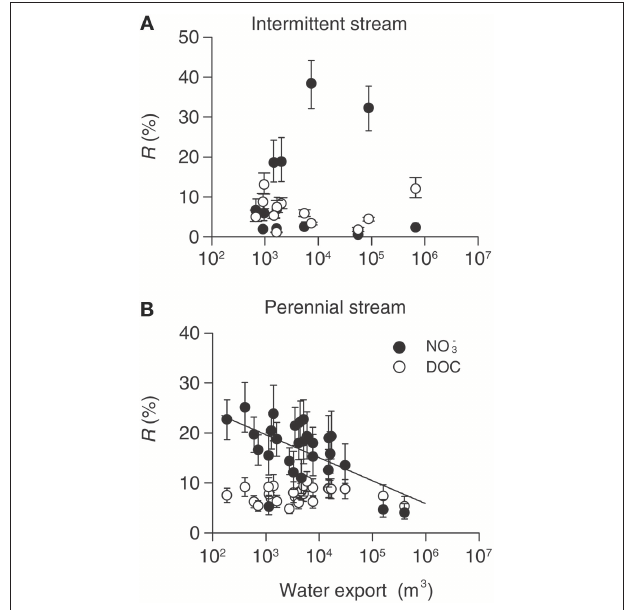
FIGURE 5 | Relationship between water export and whole-reach retention (R) of dissolved organic export (DOC) (white circles) and nitrate (NO − 3 ) (black circles) for individual storm events at the intermittent stream Fuirosos (A) and the perennial stream Font del Regàs (B) . Error bars indicate the uncertainty associated with R as explained in the text. The solid lines indicate regression models only when statistically